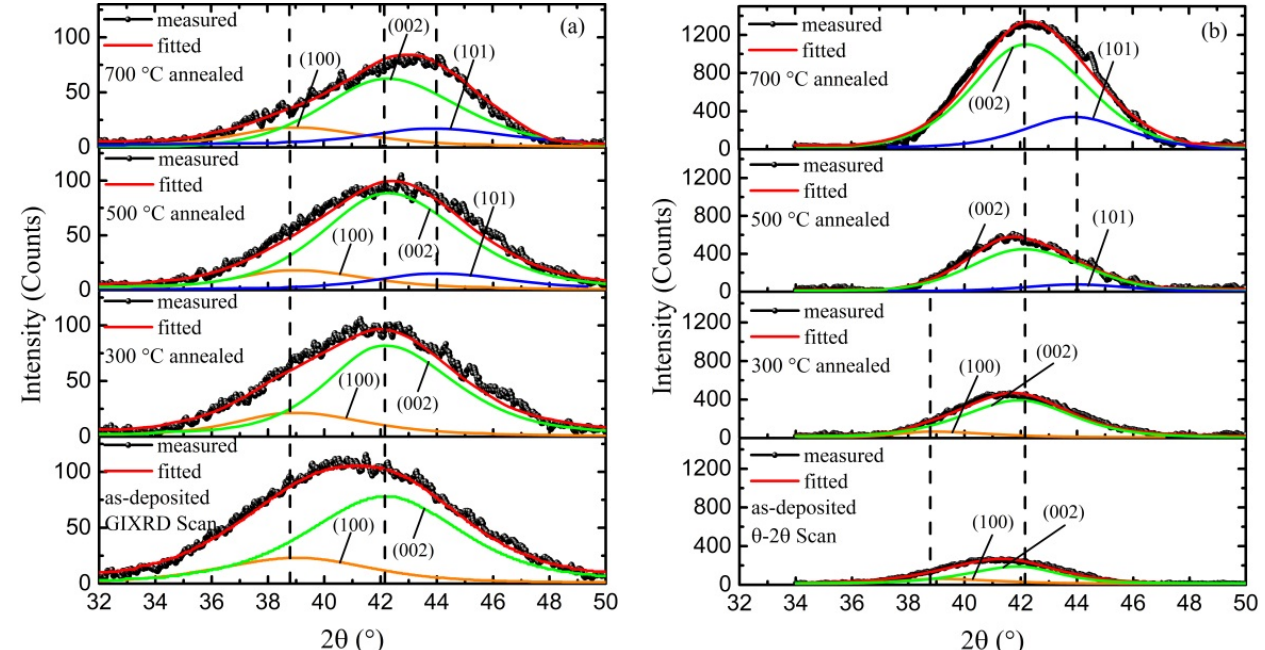
Figure 6. XRD results ( a ) GIXRD scan mode and ( b ) θ –2 θ scan mode of Ru/C multilayers under different annealing temperatures.